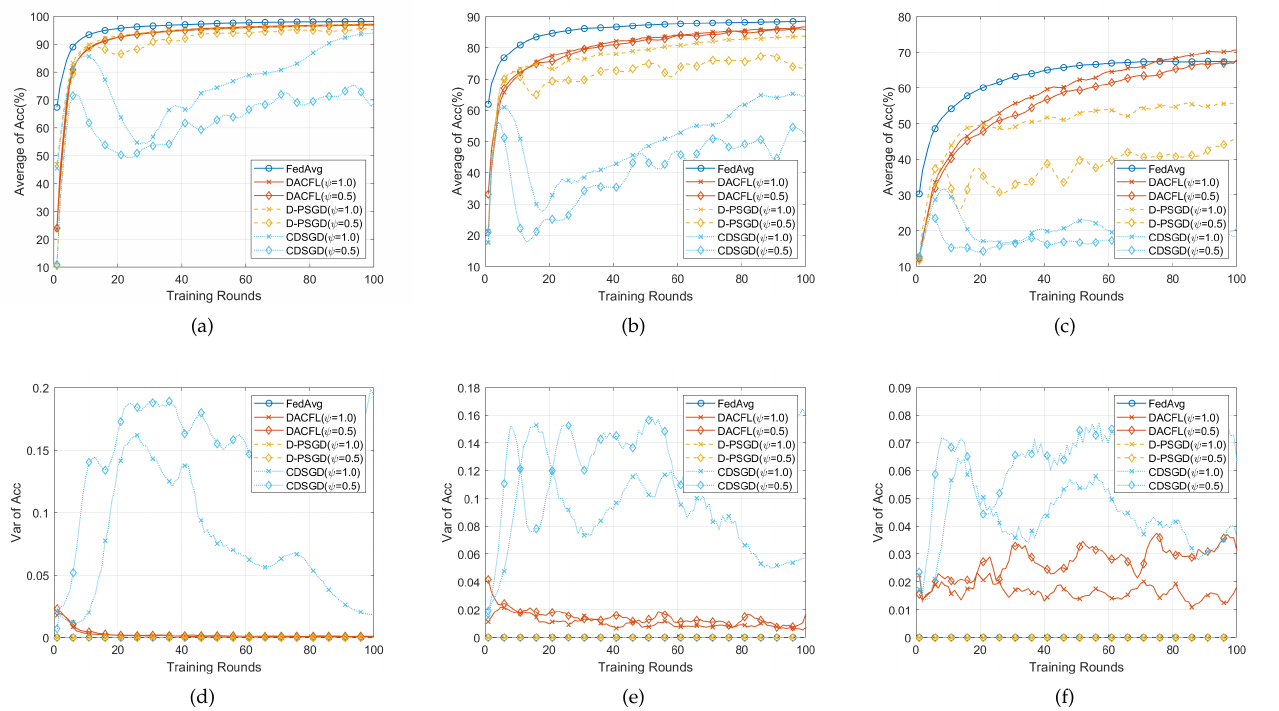
Figure 4. Performance comparison with i.i.d data and time-invariant topology. ( a , d ) on MNIST; ( b , e ) on FMNIST; ( c , f ) on